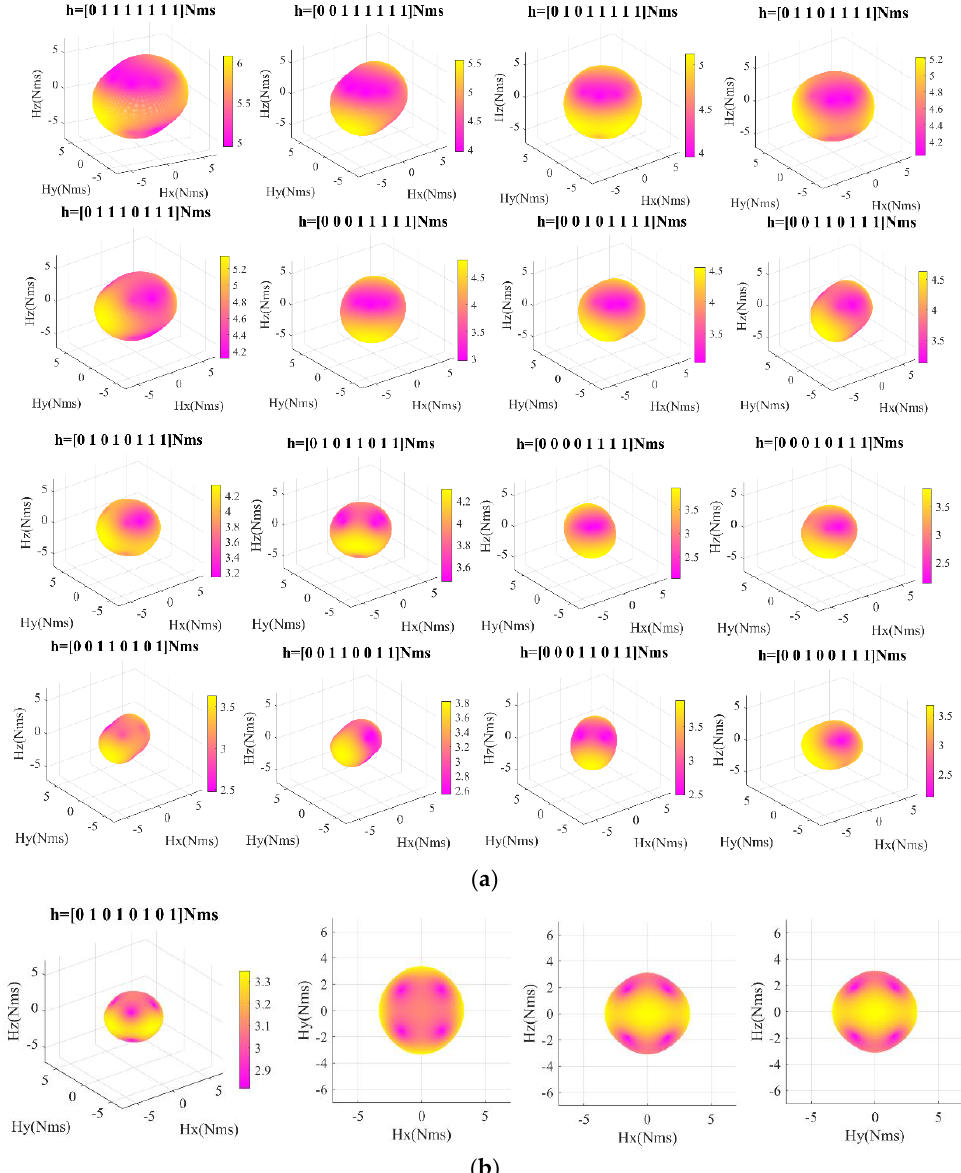
Figure 4. Failure momentum envelops of 8−SGCMGs. ( a ) Asymmetric failure, ( b ) Symmetric failure.